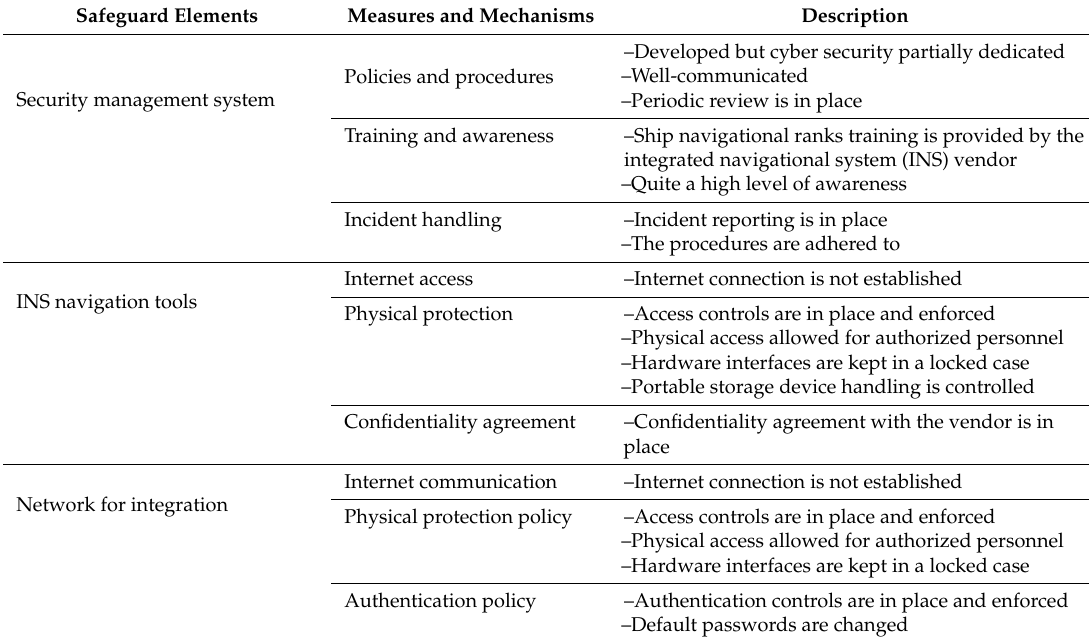
Table 2. Implemented